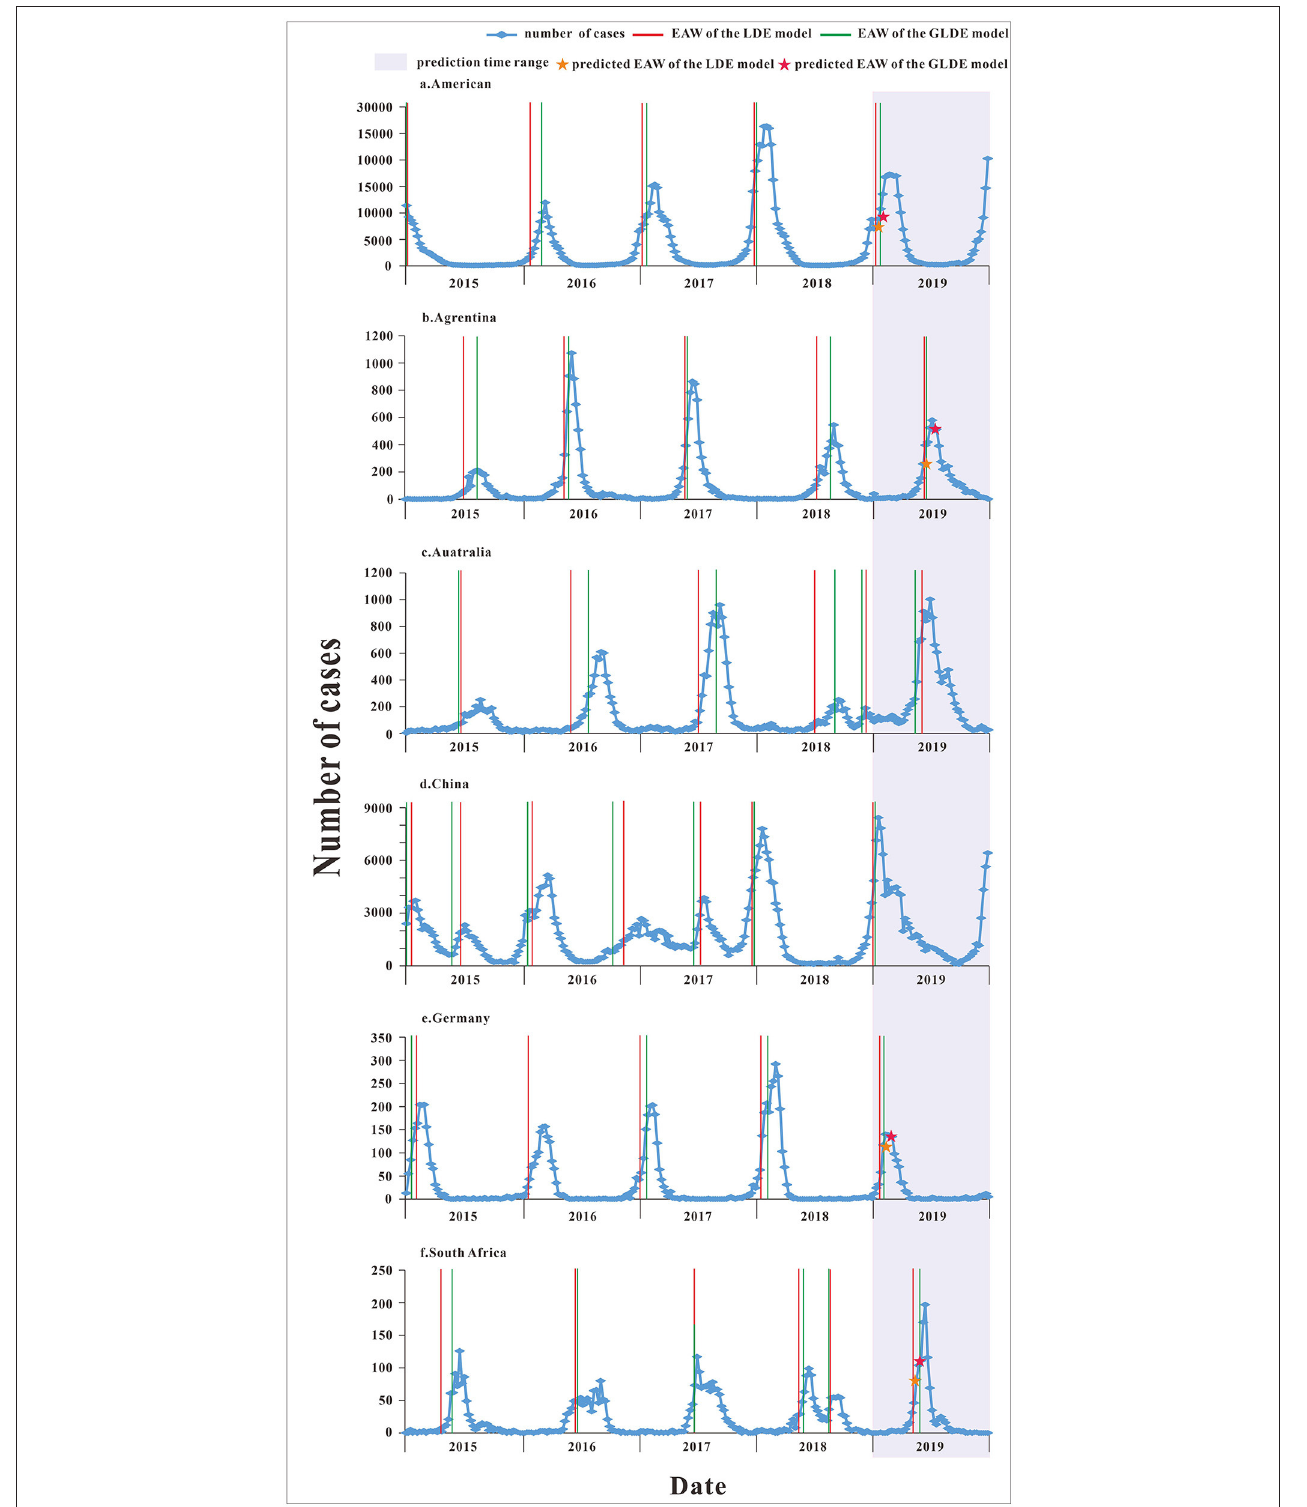
FIGURE 7 | The epidemic acceleration week of logistic and generalized logistic differential equation models in different areas. (a) American, (b) Argentina, (c) Australia, (d) China, (e) Germany, and (f) South Africa.